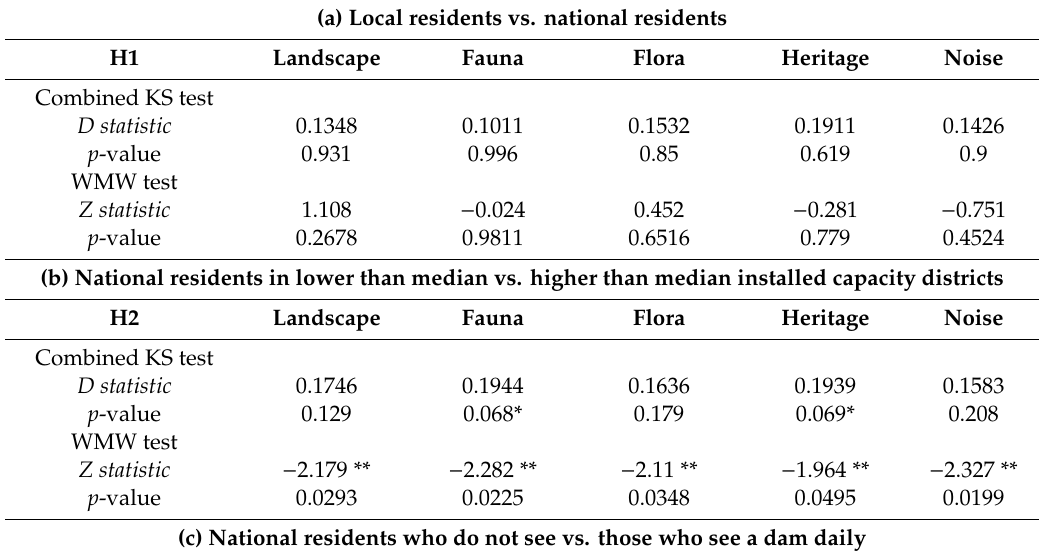
Table 2. Perceptions of local impacts of hydropower by subgroups (Kolmogorov–Smirnov test for equality of distribution and Wilcoxon–Mann–Whitney Rank Sum